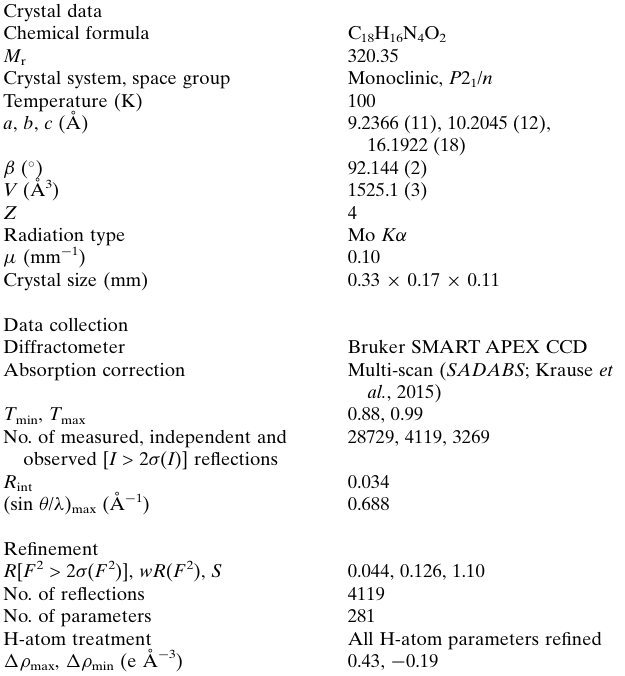
Table 2 Experimental details.